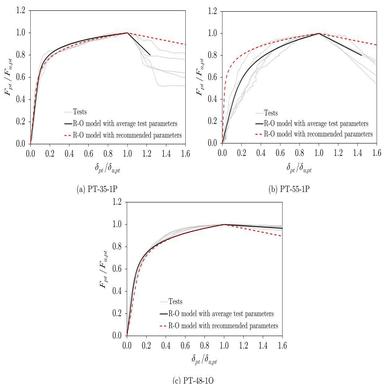
Comparisons of the proposed model using test and recommended predicted input parameters with test curves for single-board specimens.